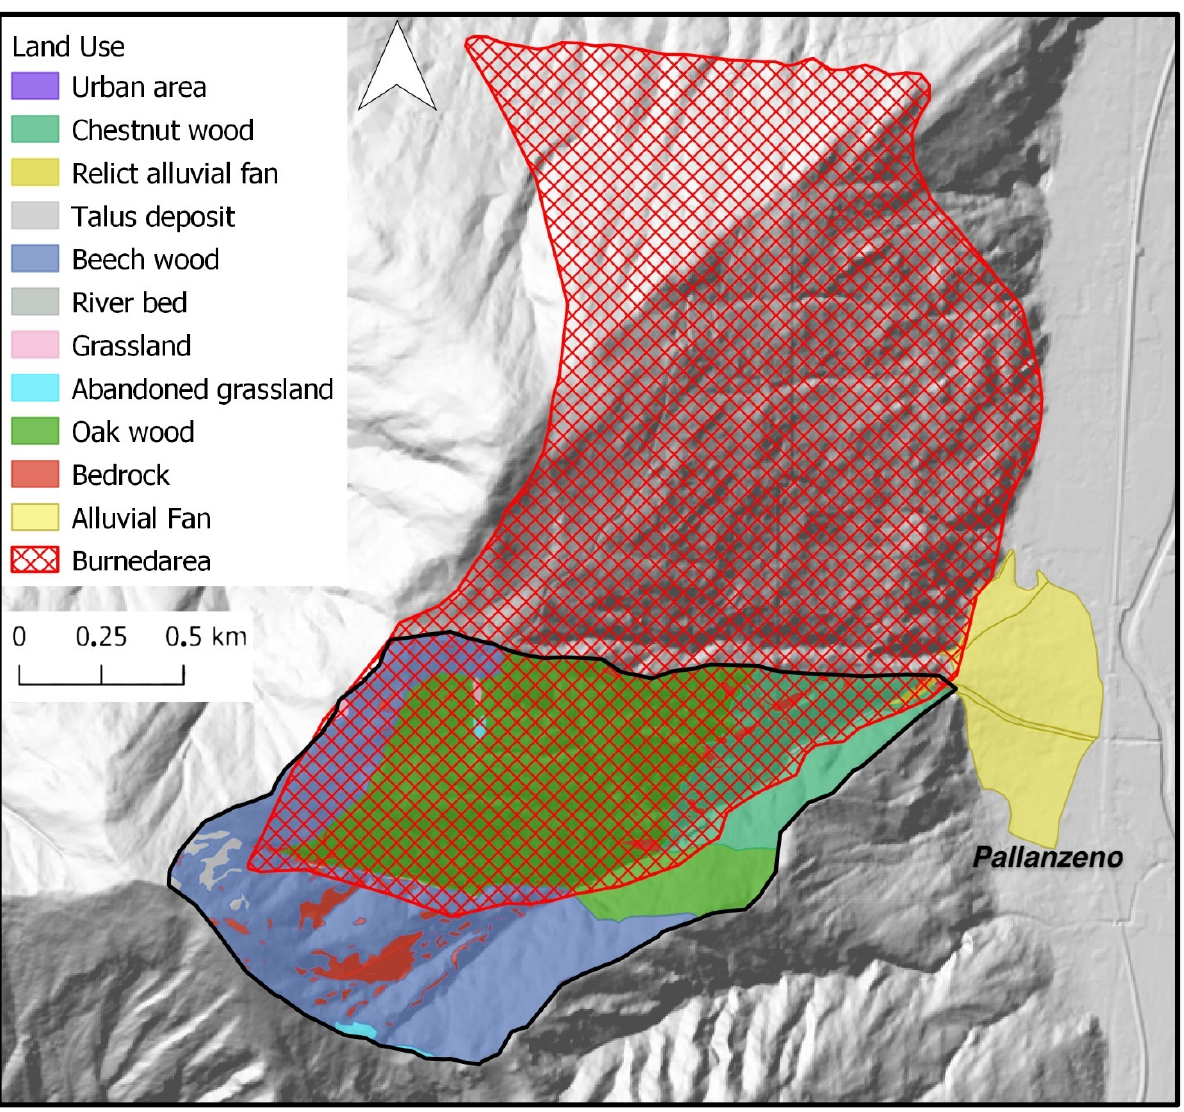
Figure 10. The Rio Casella area affected by wildfire and its intersection with land use units.